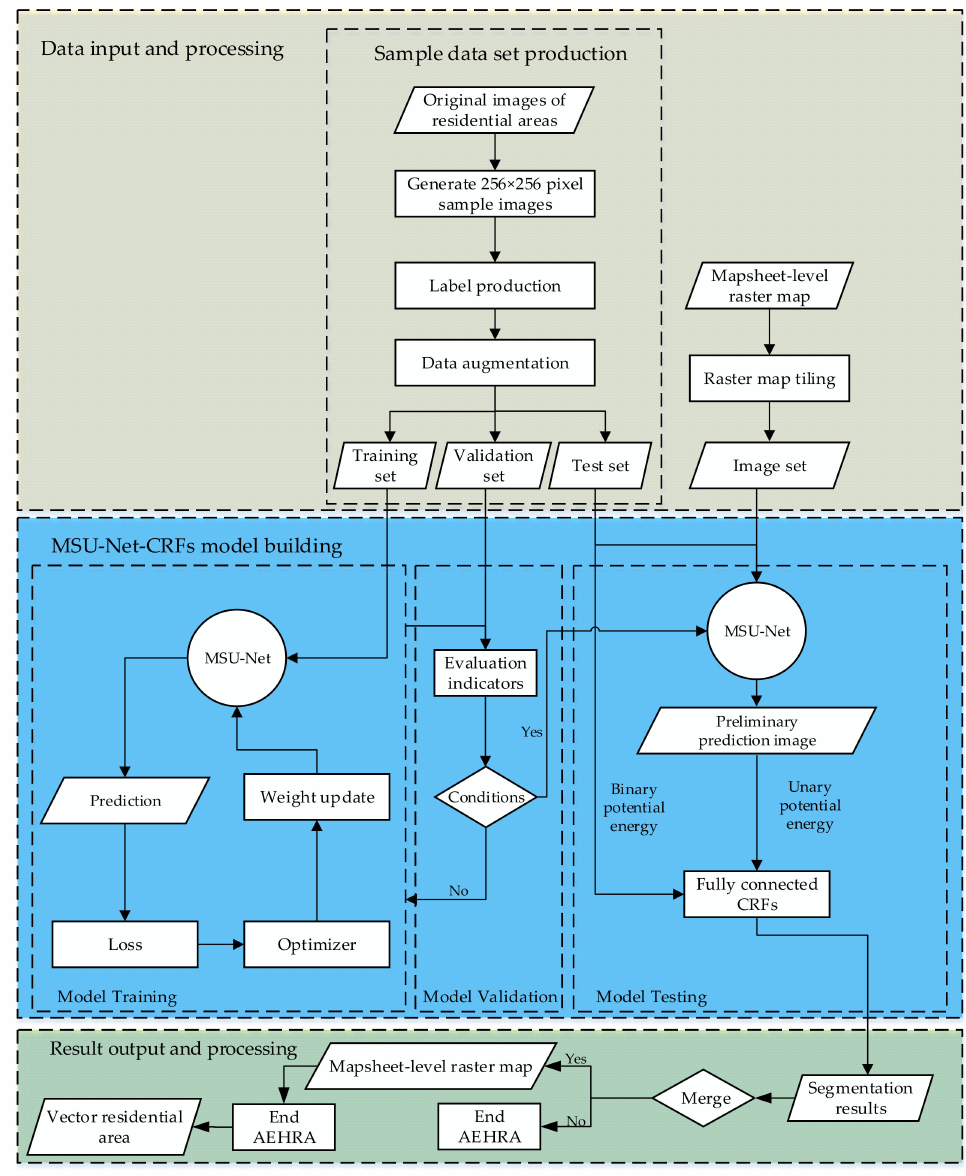
Figure 2. Workflow of